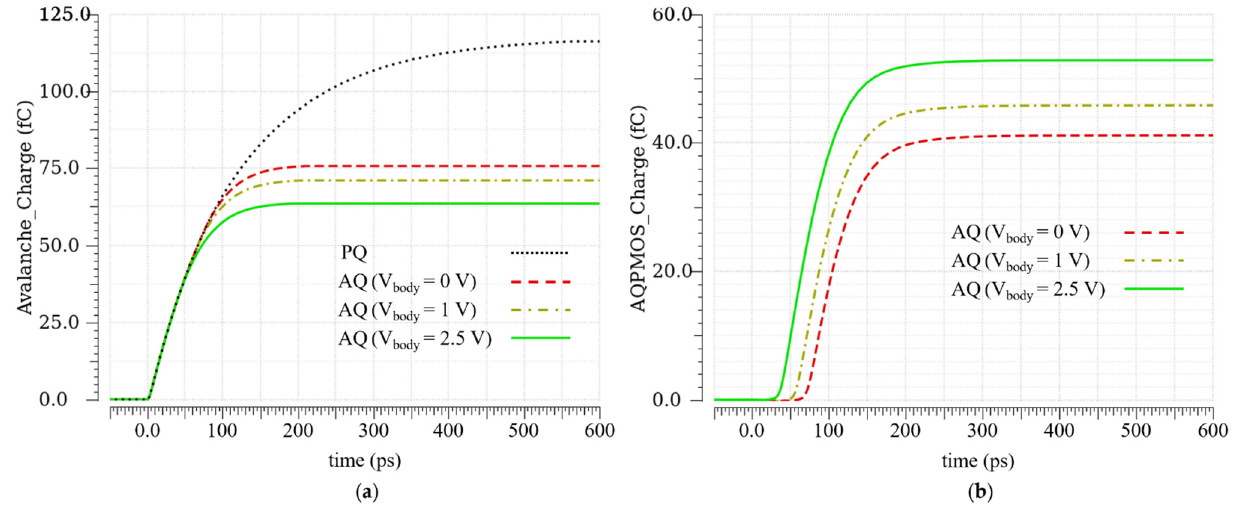
Figure 7. ( a ) Avalanche charge in the PQ and the AQ; ( b ) AQ MOSFET charge contribution during an